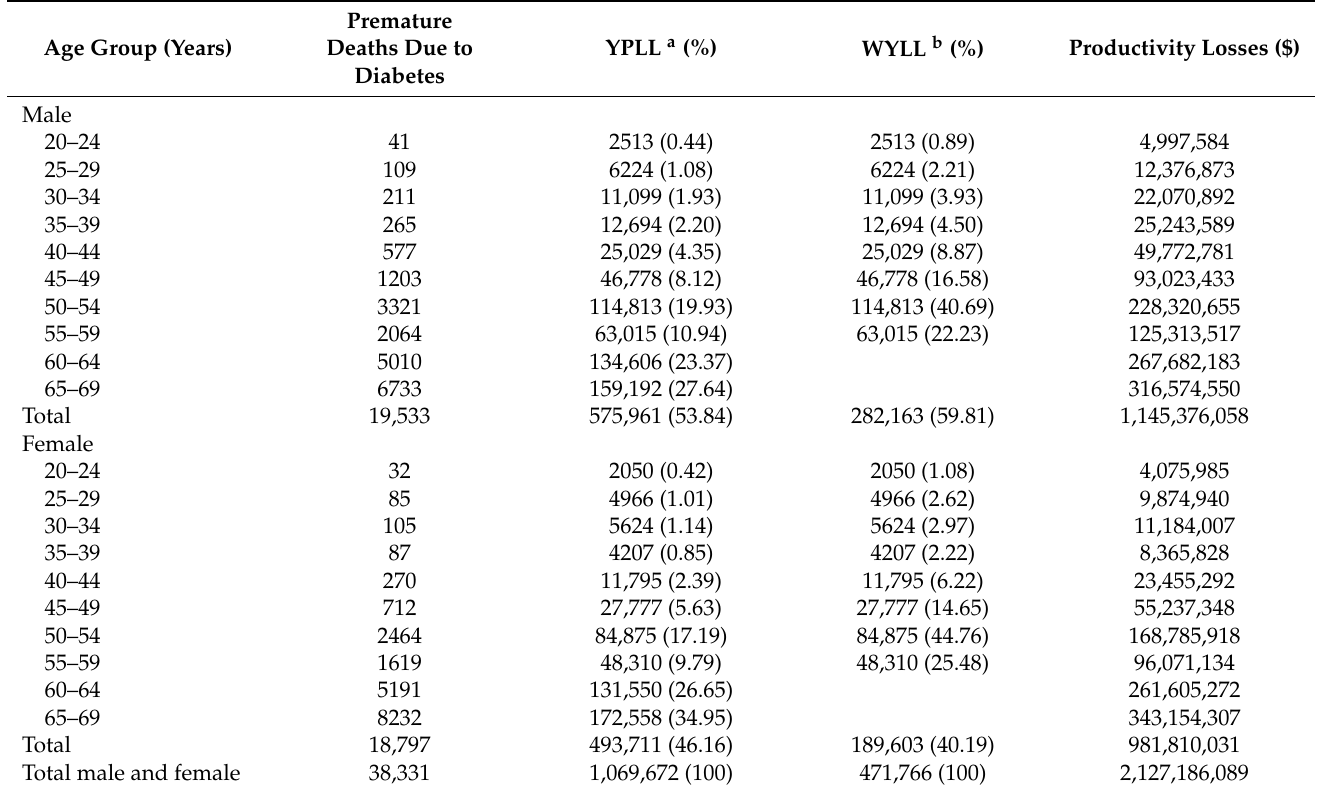
Table 4. Premature deaths, YPLL, WYPLL, and productivity losses due to diabetes for rural workers in